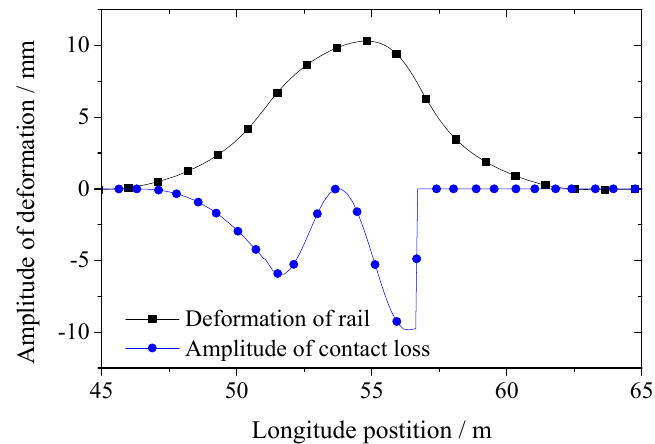
Figure 11. Contribution of rail deformation and the contact loss area in Model-B.